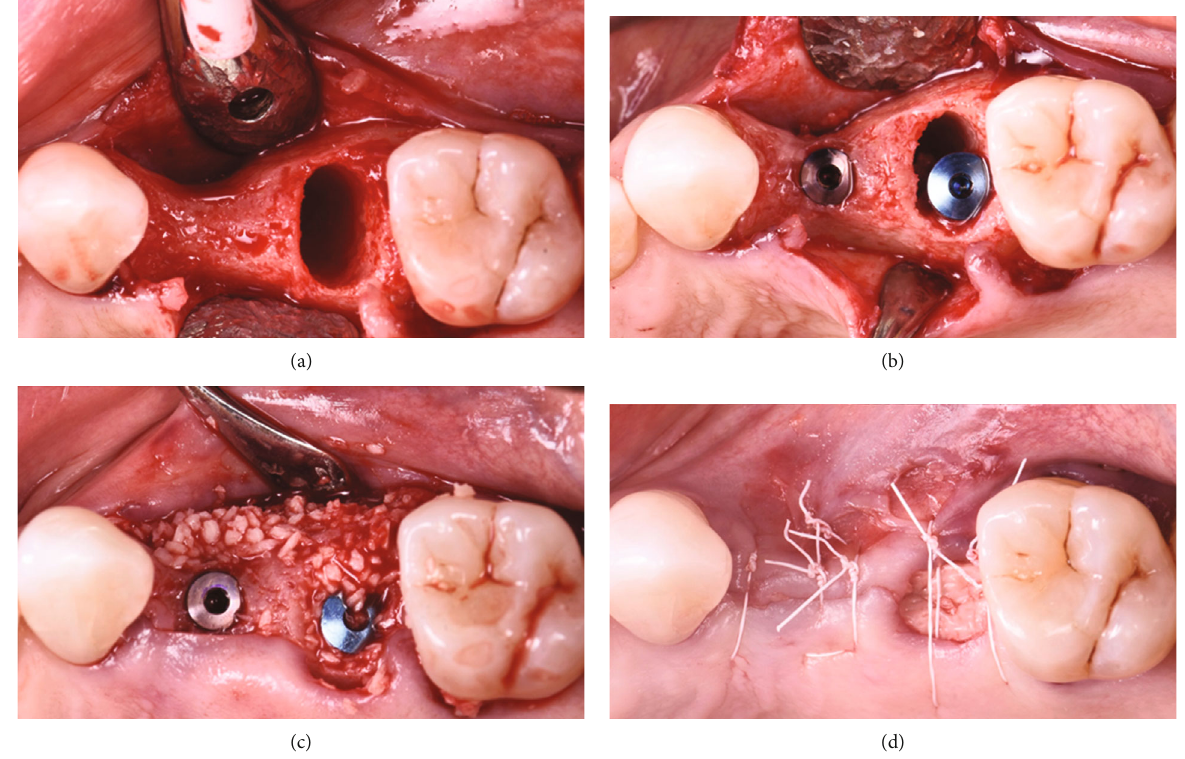
Figure 4: The sequence of the surgical management of the upper left quadrant. (a) After tooth extraction and ridge de fi ciency is noticed at the 1 st premolar site. (b) Implant placement at #25 and 24. (c) Allograft bone material is used to fi ll the buccal gap at the extraction socket and augment the buccal ridge at #24. (d) Upon fl ap closure, a tissue tear was noticed at the mucosal area of the